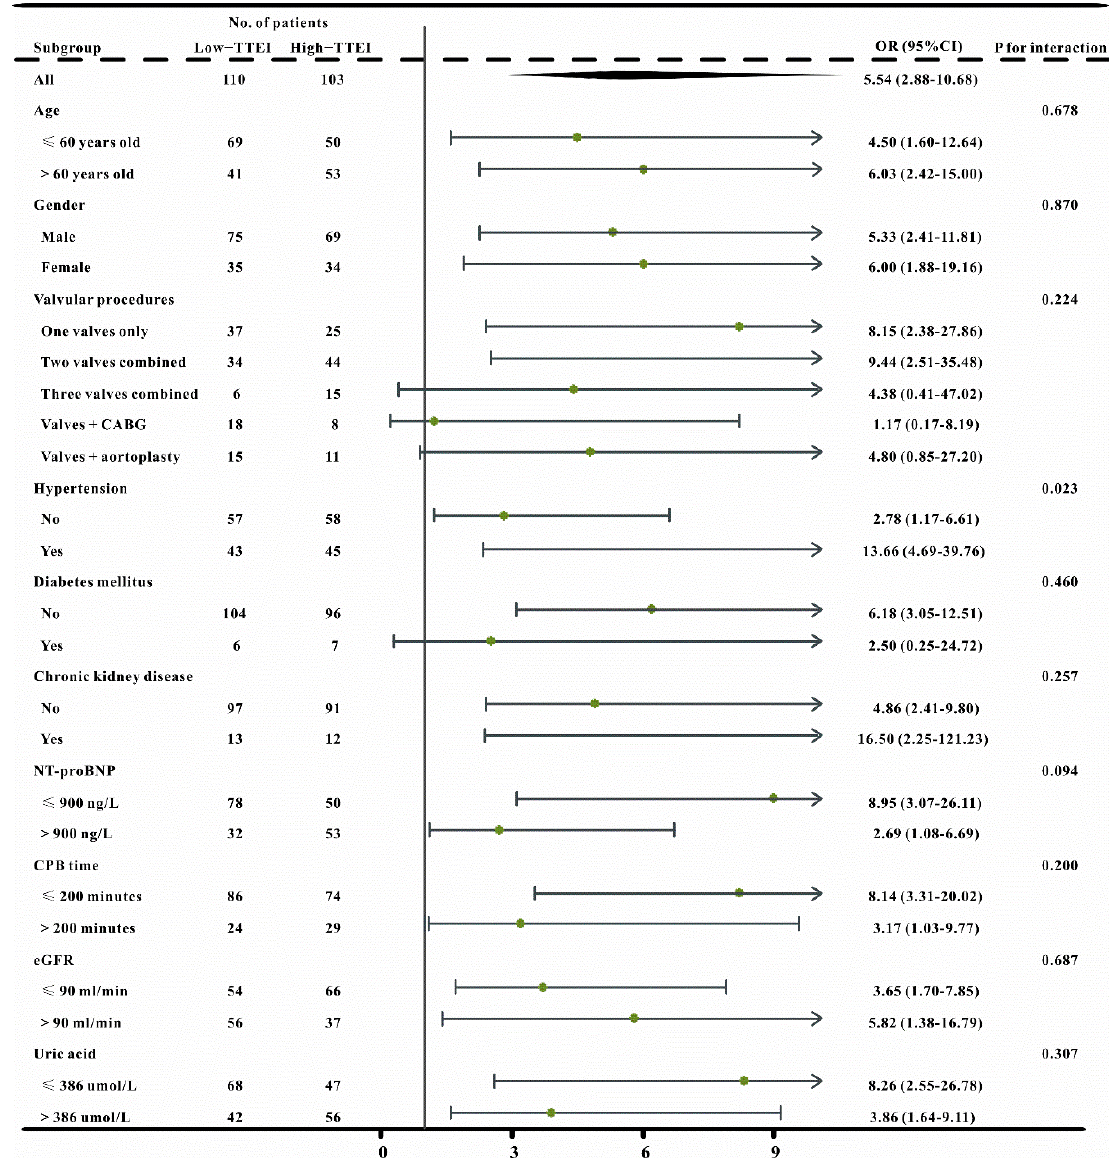
Figure 4. The forest plot revealed the results of subgroup analysis for CVS−AKI based on low and high TTEI groups in the crude cohort.